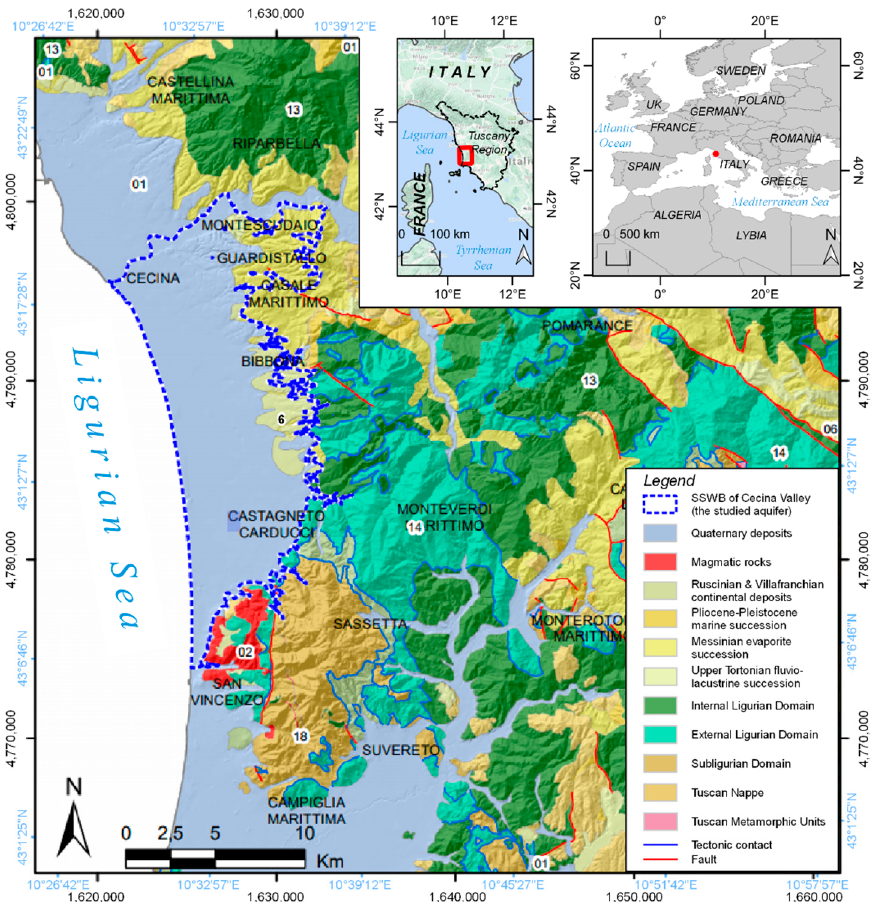
Figure 1. Geological scheme of the study area and the surrounding hills. Legend: 01—Quaternary (post-“Villafranchian”) continental and coastal deposits; 02—Magmatic rocks; 06—Ruscinian and “Villafranchian” continental succession; 07—Pliocene-Pleistocene marine succession; 08—Messinian syn- and post-evaporite succession; 09—Messinian pre-evaporite marine succession; 10—Lower Turolian (Upper Tortonian) fluvio-lacustrine succession; 11—Middle Burdigalian-Lower Tortonian marine deposits (Tyrrhenian Epiligurides Auctt.); 13—Internal Ligurian Domain; 14—External Ligurian Domain; 15—Subligurian Domain; 18—Tuscan Nappe; 21—Tuscan Metamorphic Units; blue line—Tectonic contact; red line—fault; blue dashed line—studied aquifer.